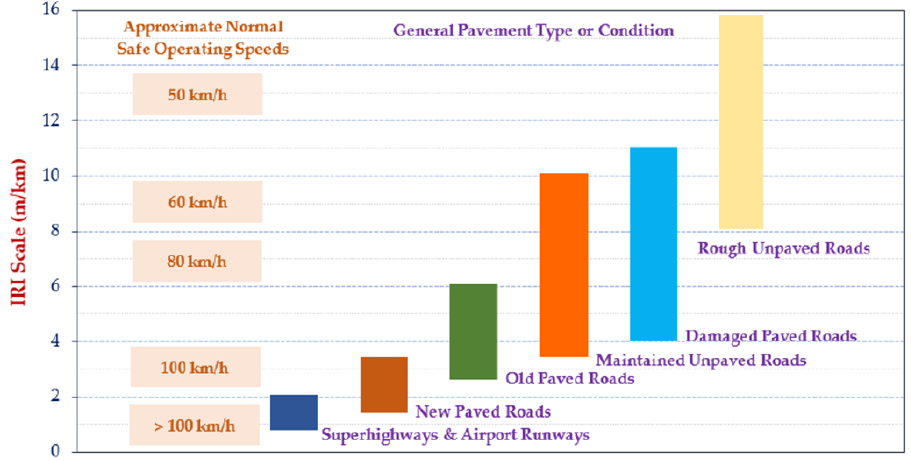
Figure 1. Illustration of the IRI scale for different pavements [33]. Table 1. The relationship of the IRI with the feelings of drivers at different vehicle speeds [34]. Ride Quality